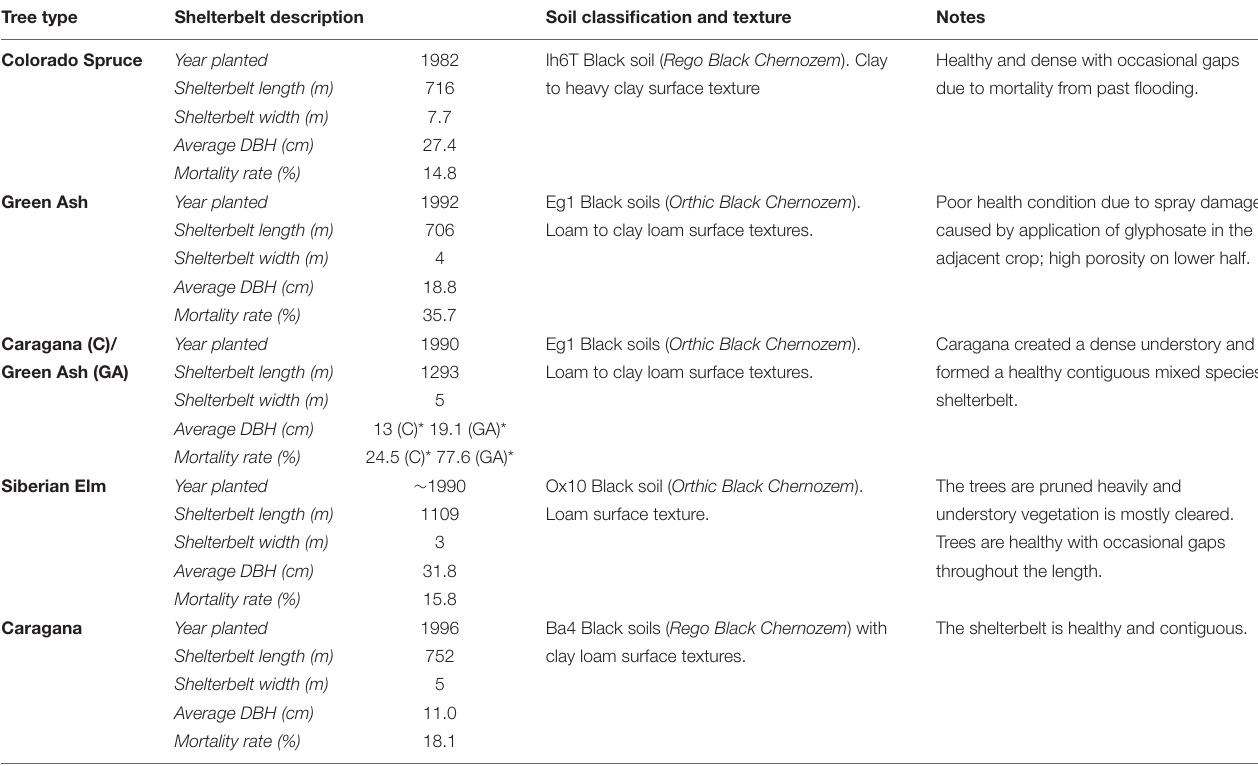
TABLE 1 | Shelterbelt age, characteristics, soil classification and texture of studied shelterbelts near Indian Head, SK, Canada. Tree type